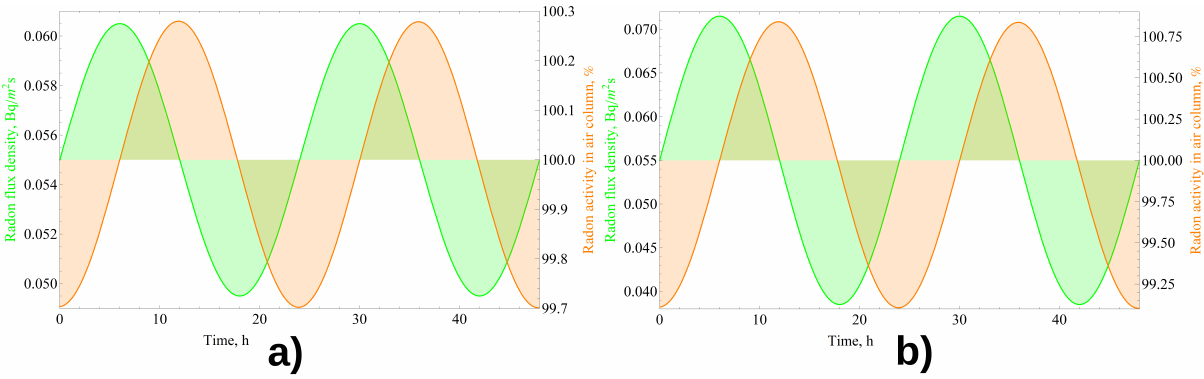
Figure 5. Dynamics of radon flux density from the soil surface and integrated radon activity in the atmosphere during 2 days at deviation of RFD from the average value: ( a ) by 10%; ( b ) by